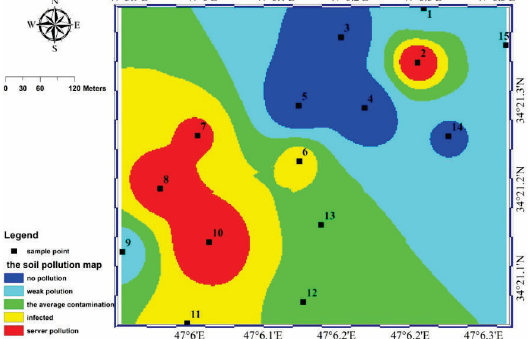
Fig. 1. General map of heavy metal pollution in the soil of the study